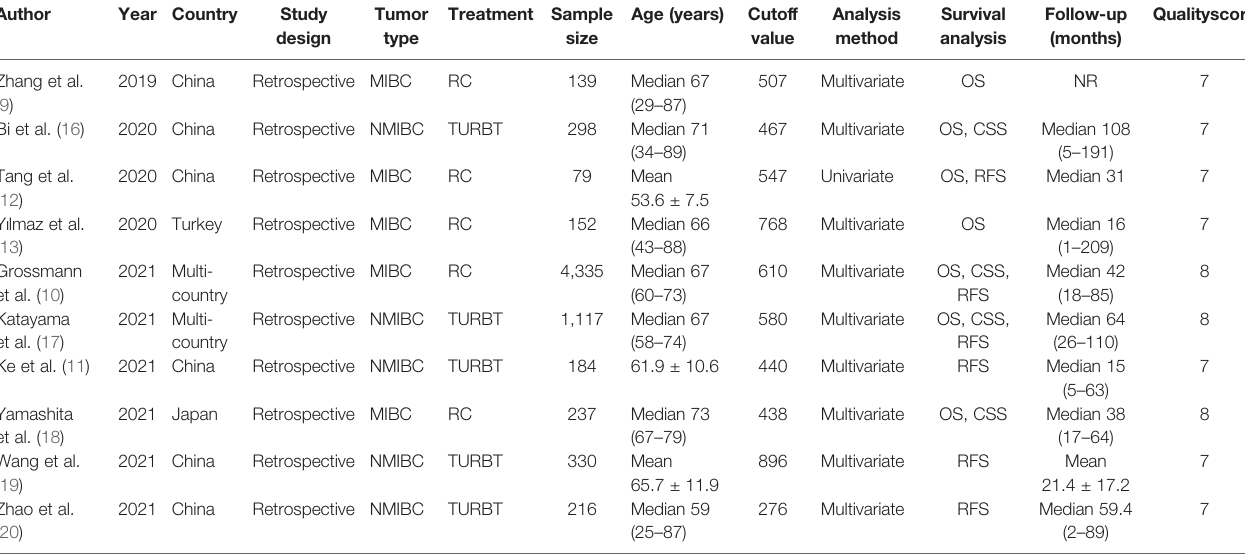
TABLE 1 | Baseline characteristics of include studies and methodological assessment.